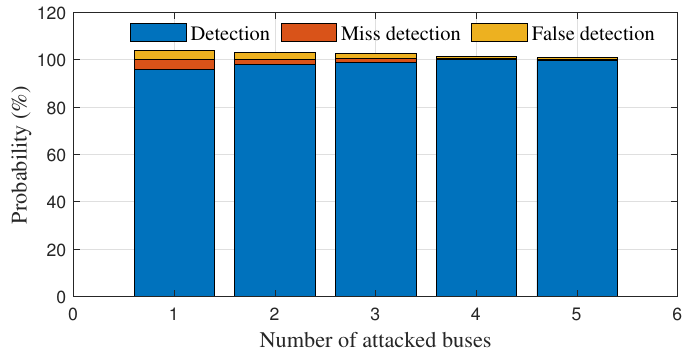
Figure 11. Probability of false data detection.